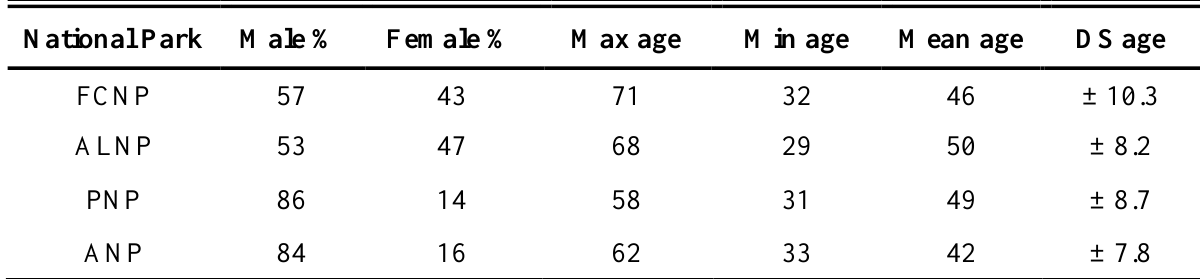
Table A6 Sex ratio and age metrics of the surveyed hiking guides National